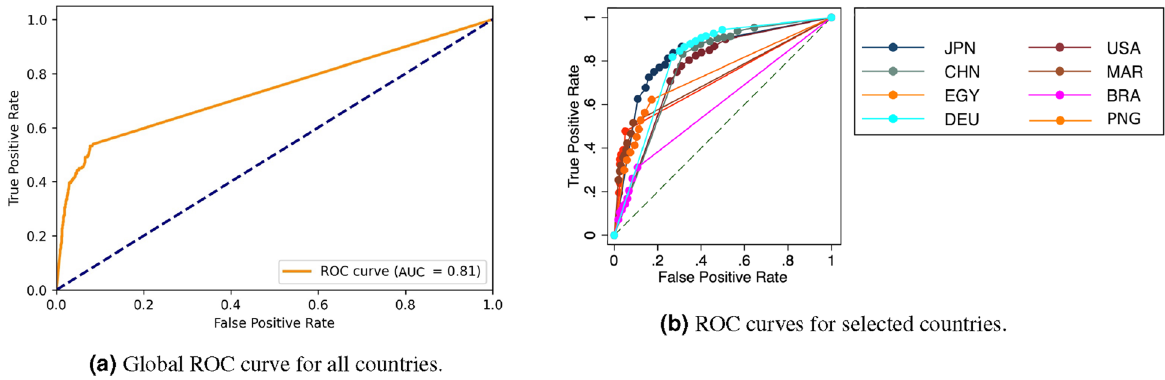
( MC ) for the year 2018. Reference dotted lines